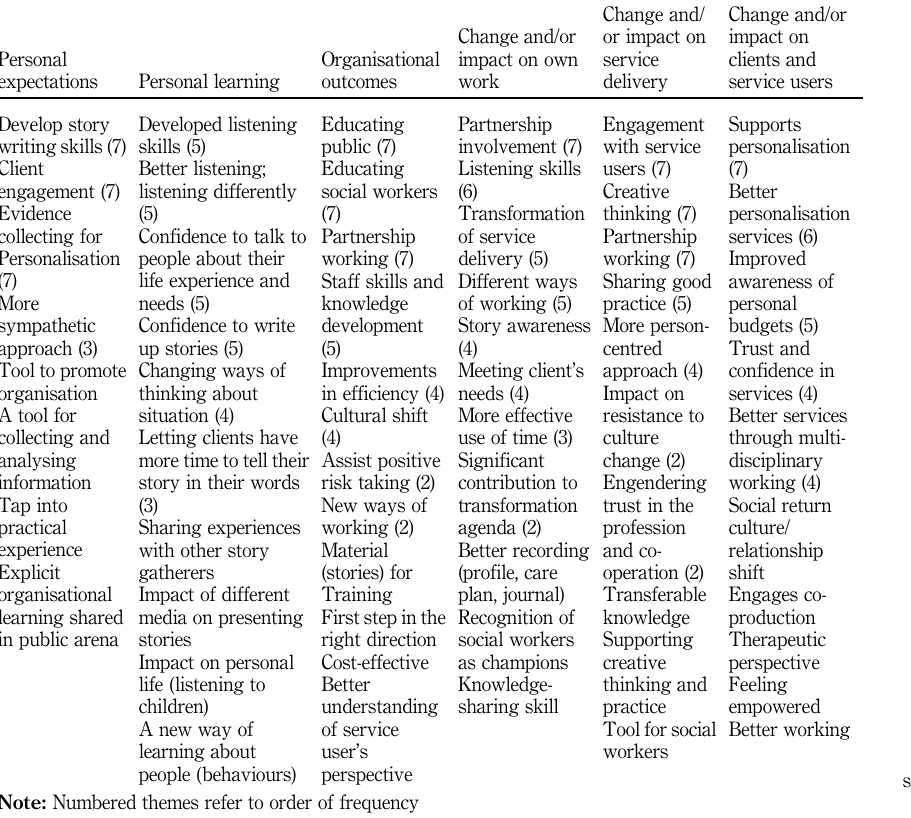
Table II. Social Care Co. ’